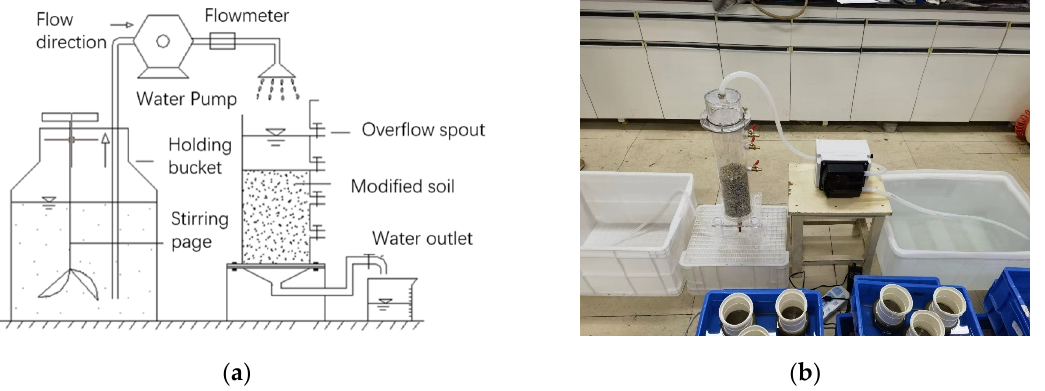
Figure 2. Diagram of the test setup : ( a ) Device construction diagram; ( b ) Actual installation